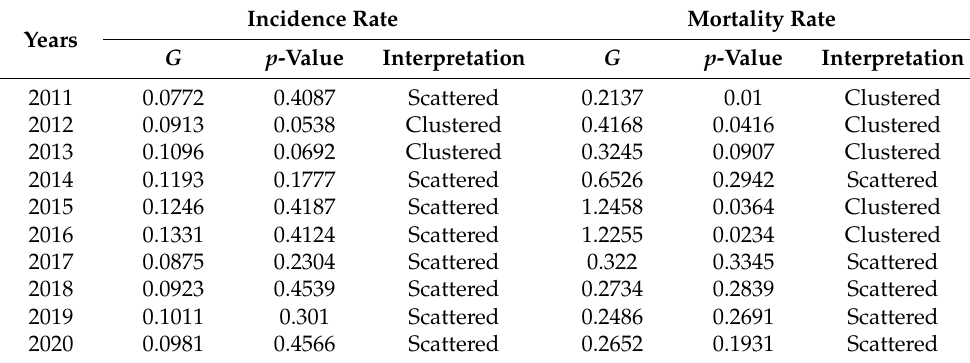
Table 2. Annual general G statistics for the notified TB incidence and mortality rates in Thailand at provincial level in 2011–2020.